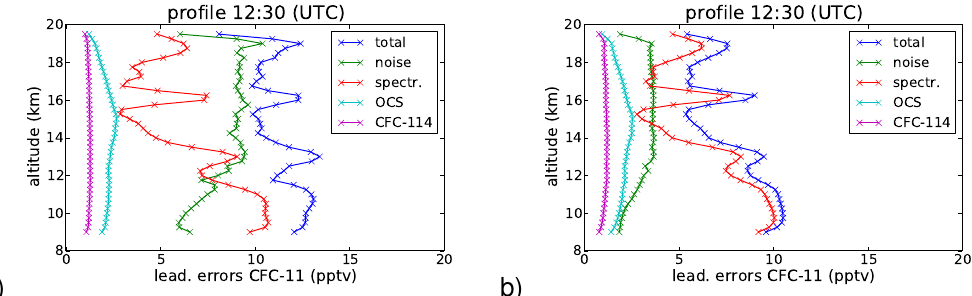
volume mixing ratios with standard vertical regu- 2